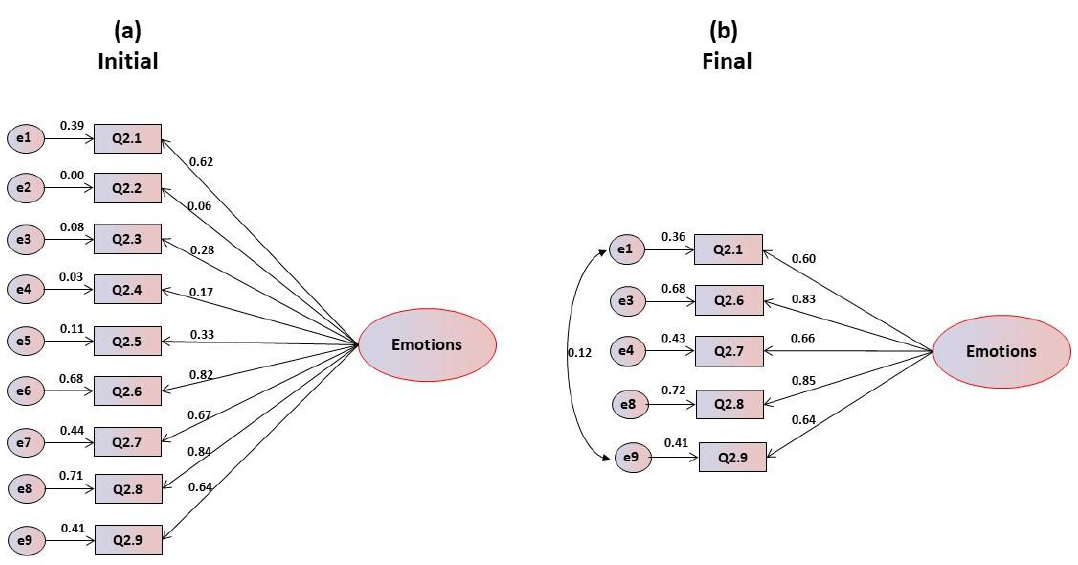
Figure 2. ( a ) Initial and ( b ) final models for the emotional motivations’ scale.